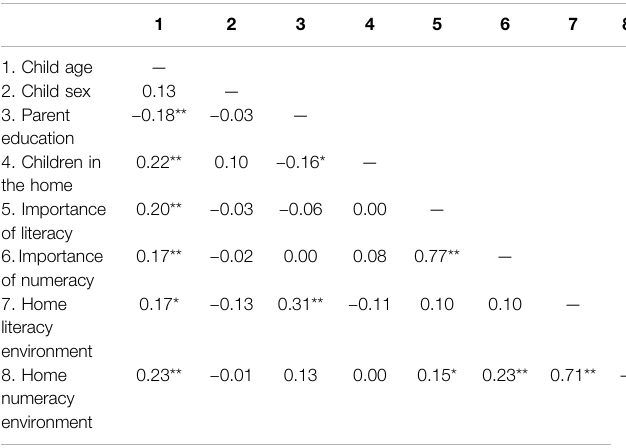
TABLE 2 | Correlations between parent and child characteristics and the home literacy and numeracy environments.